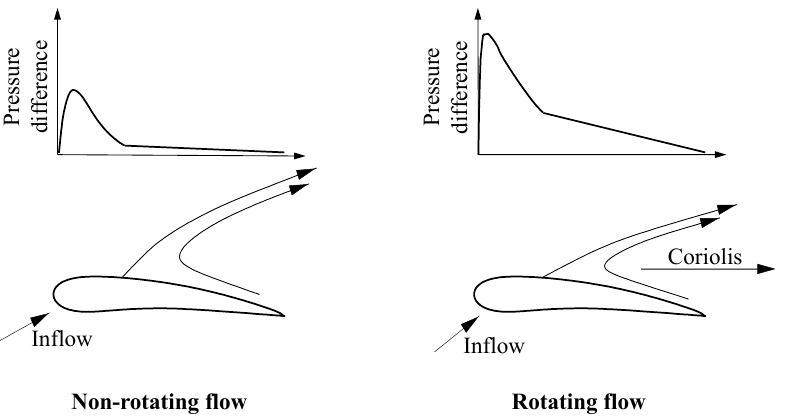
Figure 3. Favourable pressure gradient due to the Coriolis force in rotating flow (inspired from